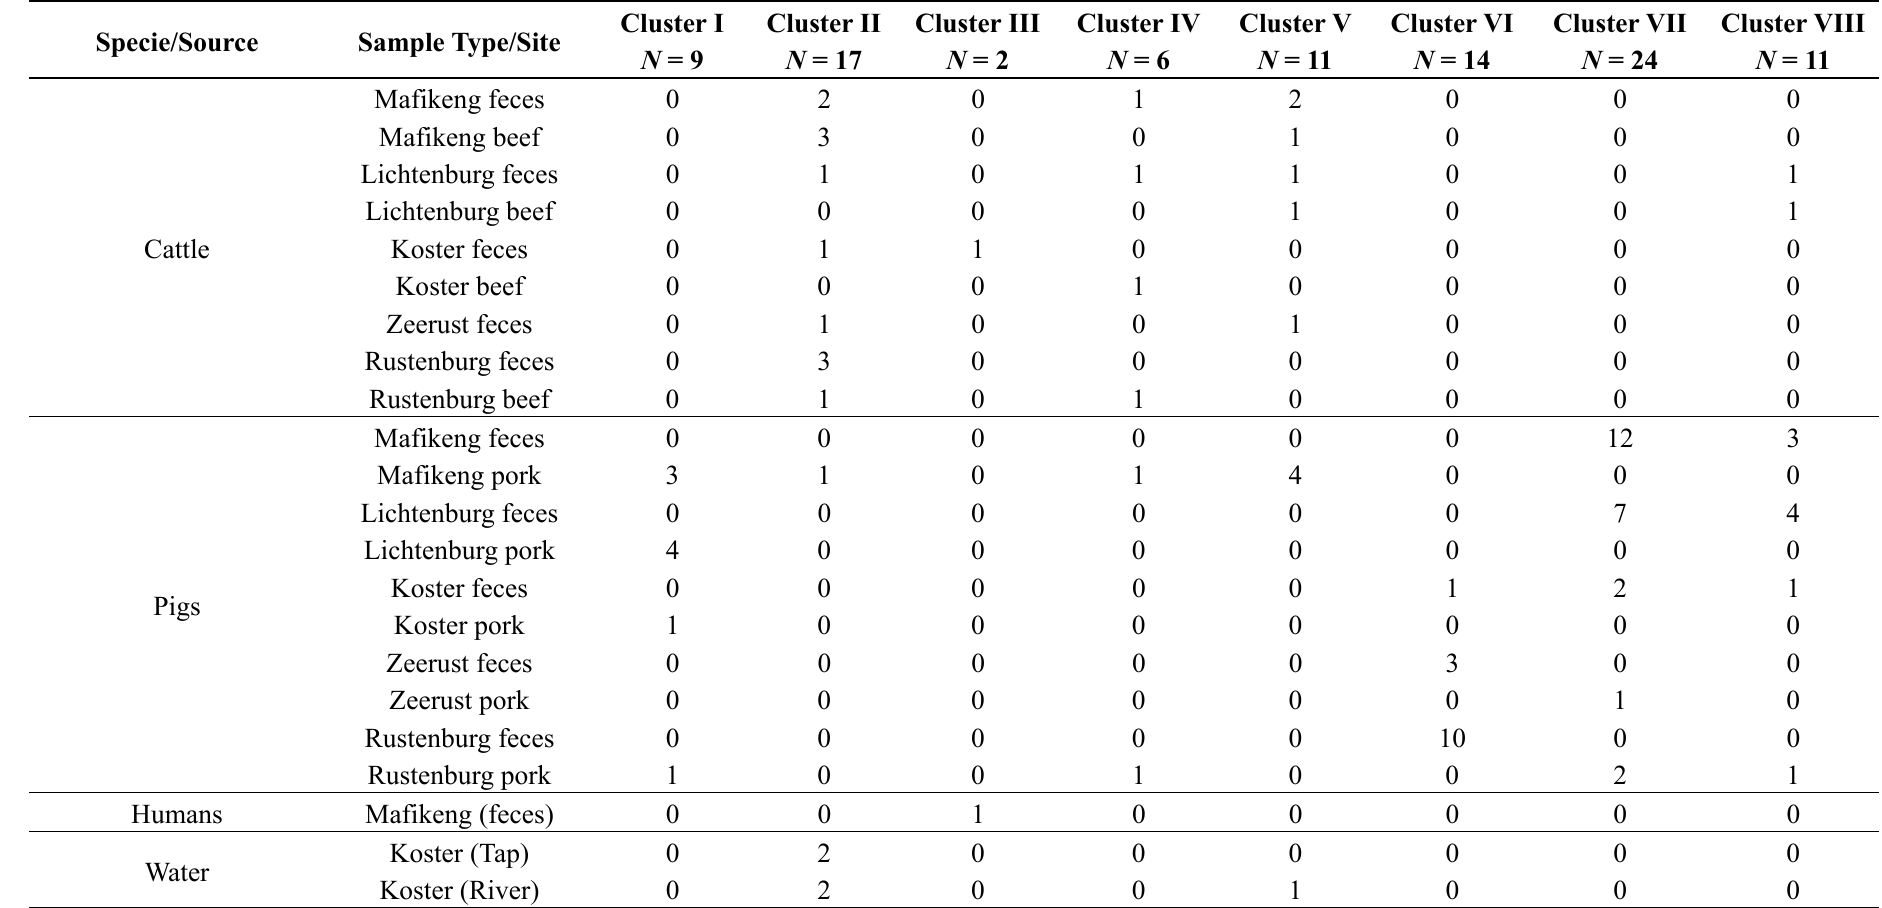
Table 1. Proportion of Escherichia coli ( E. coli ) O157:H7 from different species and/or sources with the various clusters based on the Enterobacterial Repetitive Intergenic Consensus (ERIC) Polymerase Chain Reaction (PCR) analysis. N , number of isolates with similar fingerprints/genetic